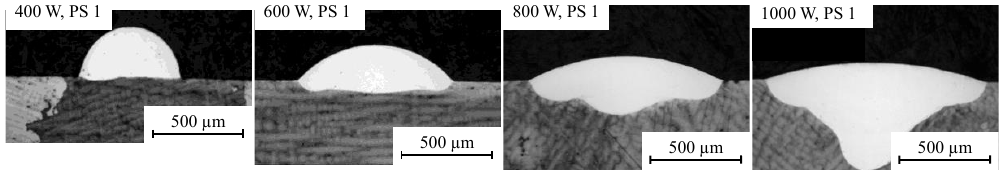
Figure 9. Weld seam geometry for varying pulse peak power and constant pulse duration. Wire-feeding rate was 2 mm/s and pulse frequency 14 Hz.